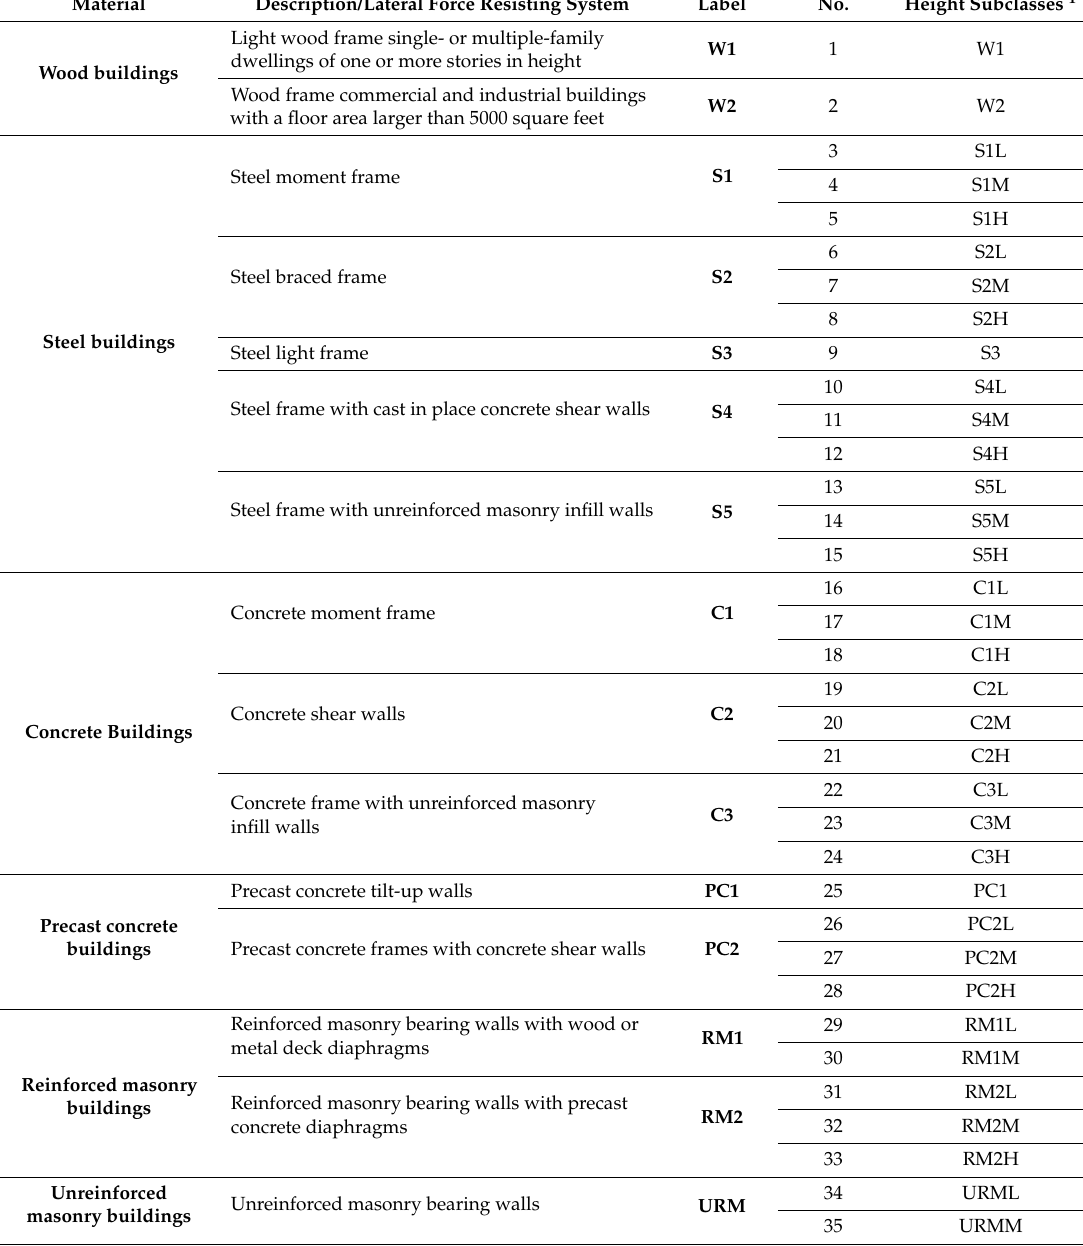
Table A1. Building types as defined by Hazus-MH